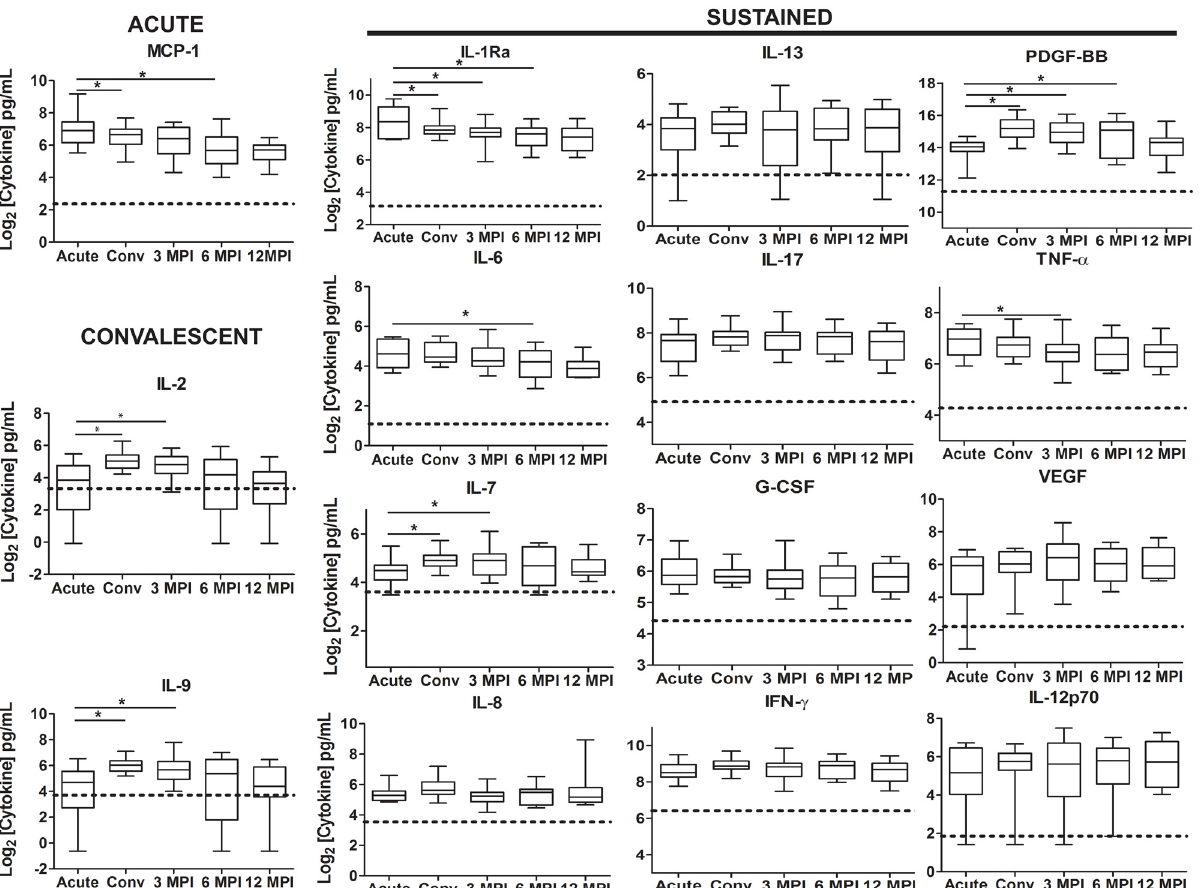
Fig 2. Kinetic profile of cytokines and chemokines significantly affected following MAYV infection. Serum samples were collected at the acute visit as well as the convalescent visit (20 ± 10 days), at 90 ± 10 days, at 180 ± 15 days, and at 360 ± 30 days after the acute visit. The serum concentrations of a variety of cytokines were assessed by a multiplex cytokine bead array. Three kinetic profiles are presented based on the peak of cytokine expression: Acute: cytokines/chemokines that peak during the acute phase (upon enrollment); Convalescent: cytokines/chemokines that peak during the convalescent phase 20 ( ± 10) days post enrollment and may remain elevated for few months after MAYV infection; and Sustained: cytokines/chemokines whose expression remain elevated up to 12 months following MAYV infection. The box plot denotes the median, 25 th percentile, and 75 th percentile cytokine levels. The whiskers denote the minimum and maximum cytokine levels observed at each time point. The horizontal dotted line represents the median cytokine values for the healthy donor controls. Data sets were evaluated by using Wilcoxon non-parametric tests to evaluate the evolution of cytokine levels at each time point post-infection ( * p <